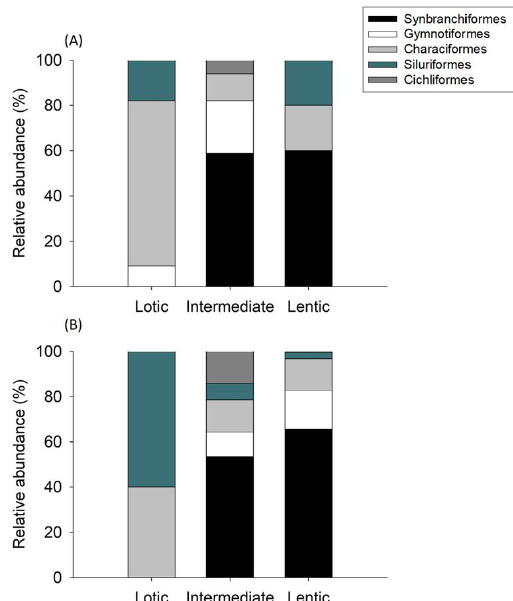
Figure 5. Relative abundance values of each order of the fish fauna associated to macrophyte banks in the distinct compartments of Palmeiras (A) and Retiro (B) SHPs reservoirs, Sapucaí-Mirim River (SP, Brazil).